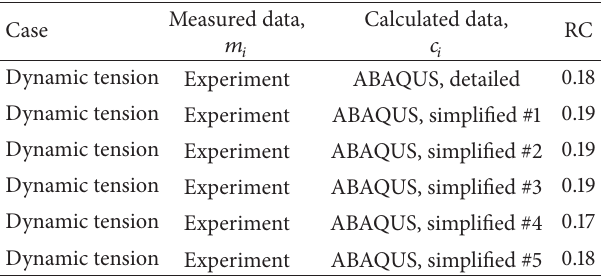
Table 1: Russell comprehensive error (RC) results.